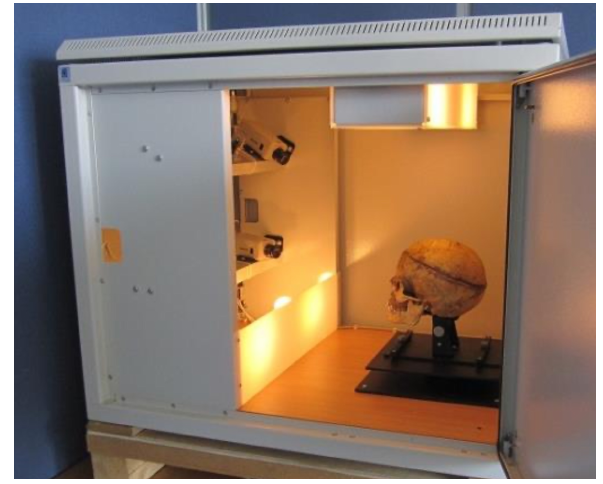
Figure 3. Automated digital photogrammetric system